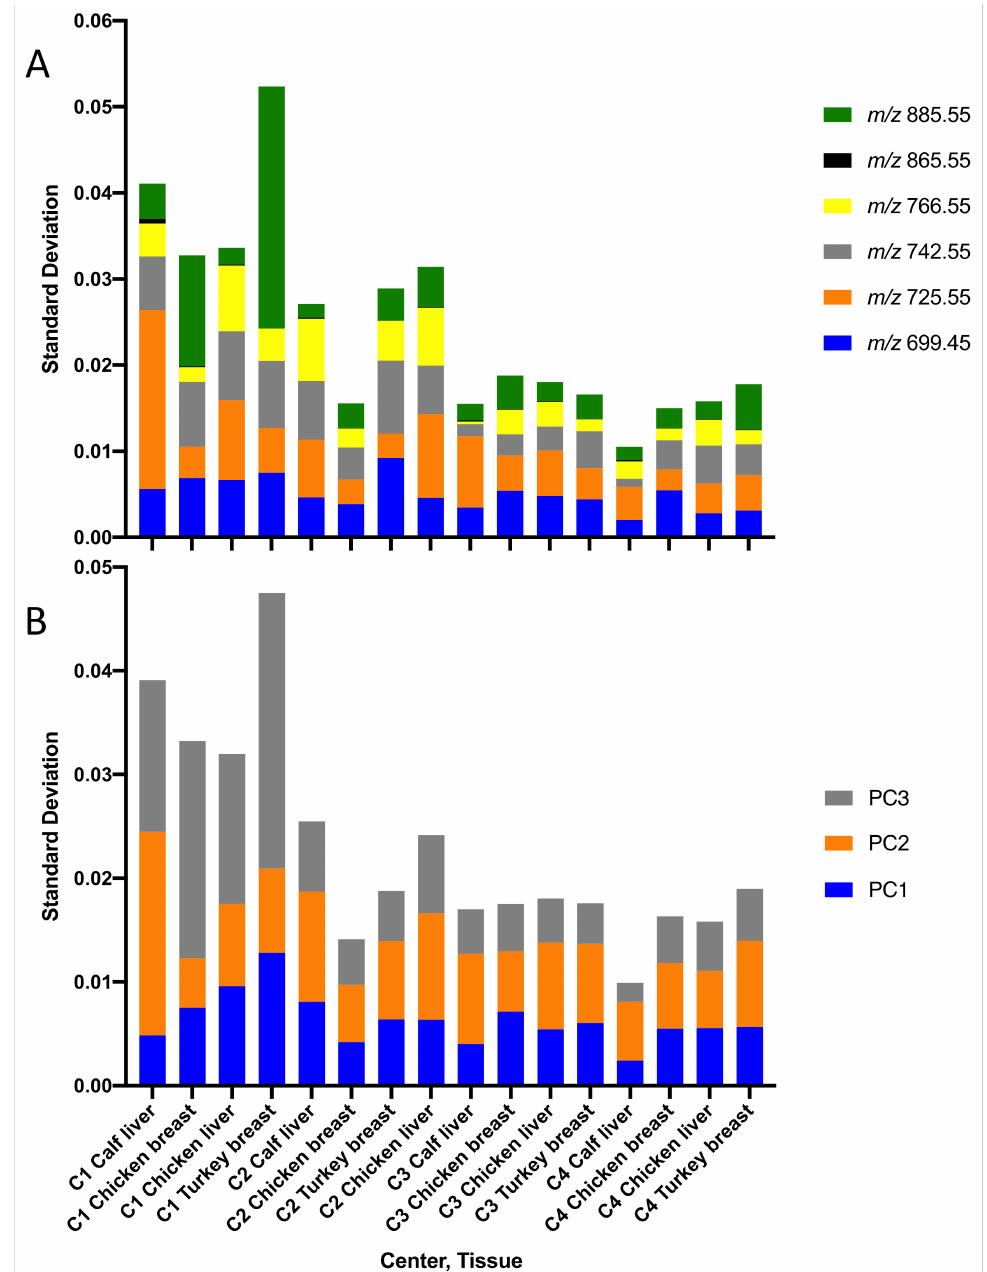
Figure 6. Standard deviation of selected phospholipid peaks and principal components. Assessment of variability in major phospholipid peaks ( A ) and principal components 1–3 for local food grade meats analyzed by REIMS at each center ( B